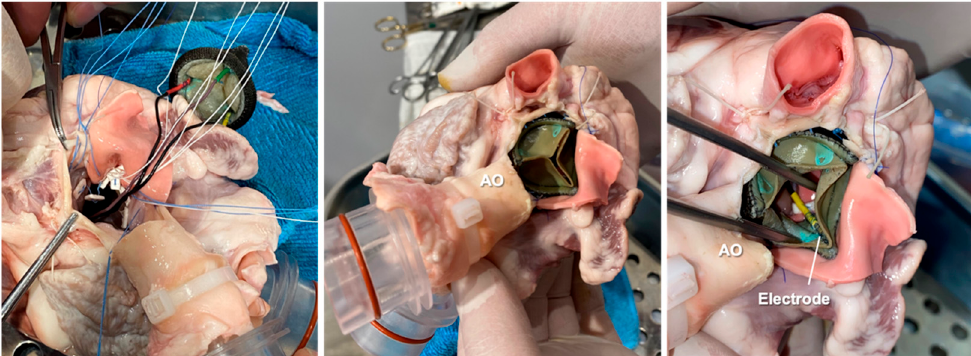
Figure 3. Surgical implantation of the sensorized BHV inside the explanted porcine heart. AO = aorta.